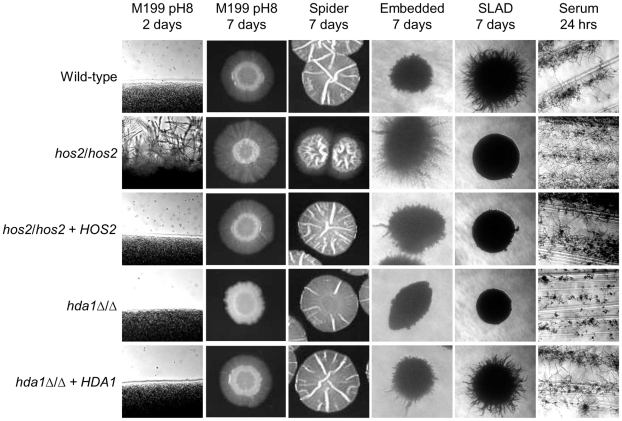
HDACs regulate filamentation on solid media.Overnight cultures of C. albicans wild-type (DAY185), hos2/hos2 (DAY1252), hos2/hos2 +HOS2 (DAY1250), hda1Δ/Δ (DAY1240), and hda1Δ/Δ +HDA1 (DAY1241) strains grown in YPD at 30°C were: spotted onto M199 buffered to pH 8; serially diluted in PBS up to ∼100 CFU and plated on Spider and SLAD media; diluted 1∶1000 in 2 ml fresh YPD, incubated 4 hrs at 30°C and 8 µl were plated in embedded agar; streaked in synthetic complete medium supplemented with 4% bovine calf serum (BCS). All plates were incubated at 37°C, except for embedded agar which was incubated at 23°C. A minimum of three independent repetitions for each filamentation assay was performed.